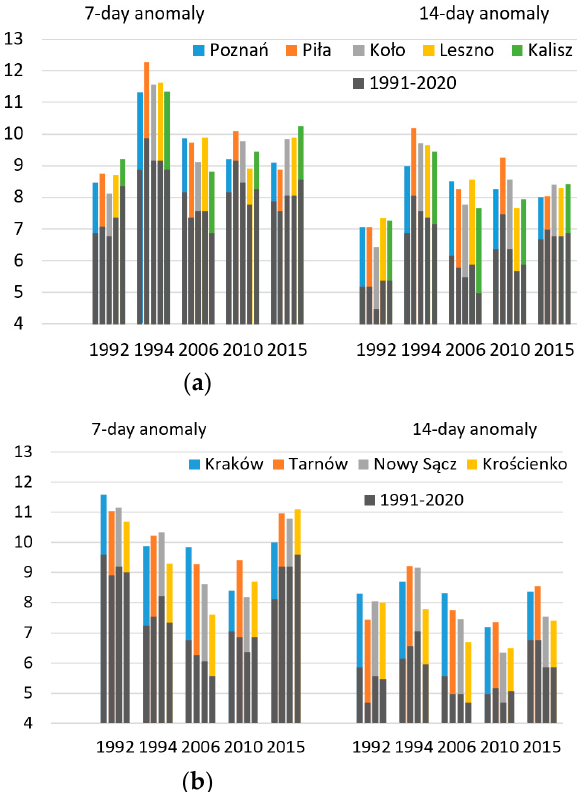
Figure 3. The highest 7-day and 14-day anomalies of the daily maximum temperature during the hottest summers compared with two reference period: 1961–1990 (colored bars) and 1991–2020 (dark grey bars) in selected stations: ( a ) Wielkopolska; ( b ) Ma ł opolska.